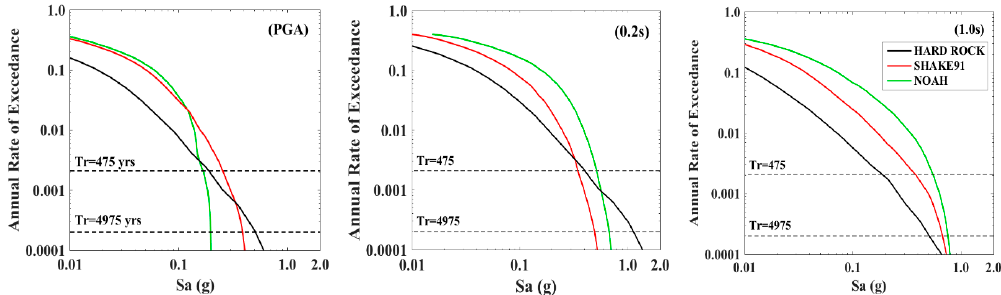
Figure 14. Hazard curves calculated using the Full Probabilistic Stochastic Method (SM), for three different spectral periods (PGA, 0.2 s, 1.0 s). Time histories on: hard rock (V S30 = 2600 m/s, black), soft soil obtained with SHAKE91 site response code (red), soft soil obtained with NOAH site response code (green).